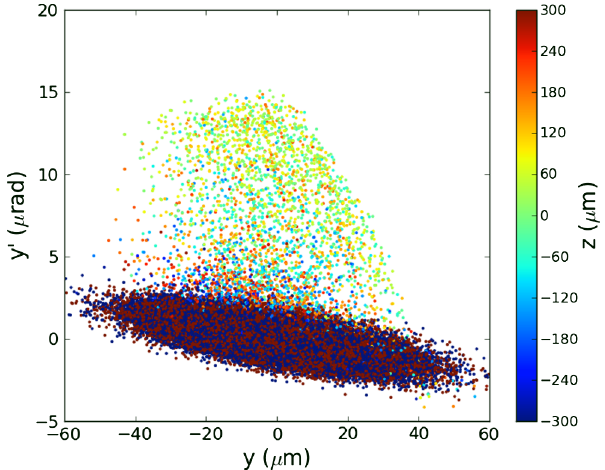
m.FIG. 10. Phase space for y versus y 0 at the crossing point at 8.3 m right after the kick.